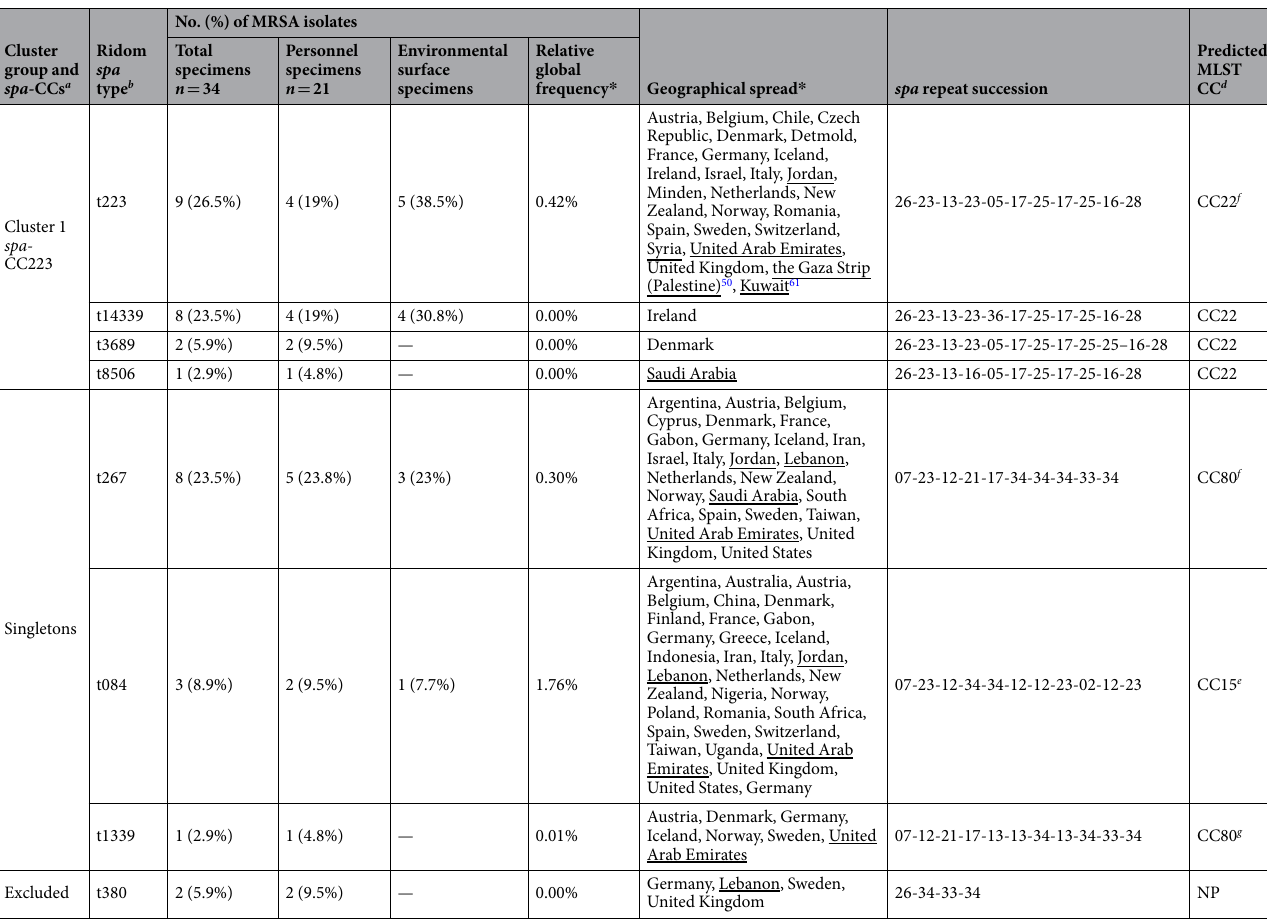
Table 4. Frequencies, geographical spread, repeat successions, and predicted clonal complexes (CCs) of the spa types detected in this study. * Based on data from the Ridom StaphType database (http://spa.ridom.de/ frequencies.shtml), last accessed on 15 November 2016, unless otherwise stated. Countries from the Arab world are double-underlined. a spa- CC: denotes spa clonal complex as determined by the Based Upon Repeat Pattern (BURP) algorithm in the Ridom StaphType software with a distance cost of ≤ 5; excluded: denotes entries excluded from BURP clustering because the spa repeat pattern comprised fewer than five repeats. b Nomenclature according to Harmsen et al . 91 ; the spa types shown are based on the Ridom StaphType software. c A minus sign ( − ) indicates the absence of the spa type. d MLST CC: denotes predicted clonal complexes based on multi-locus sequence typing. e According to the Ridom SpaServer (http://spaserver.ridom.de). f Based on data from 98 . g Based on data from 99 . NP: not predictable (not yet assigned to